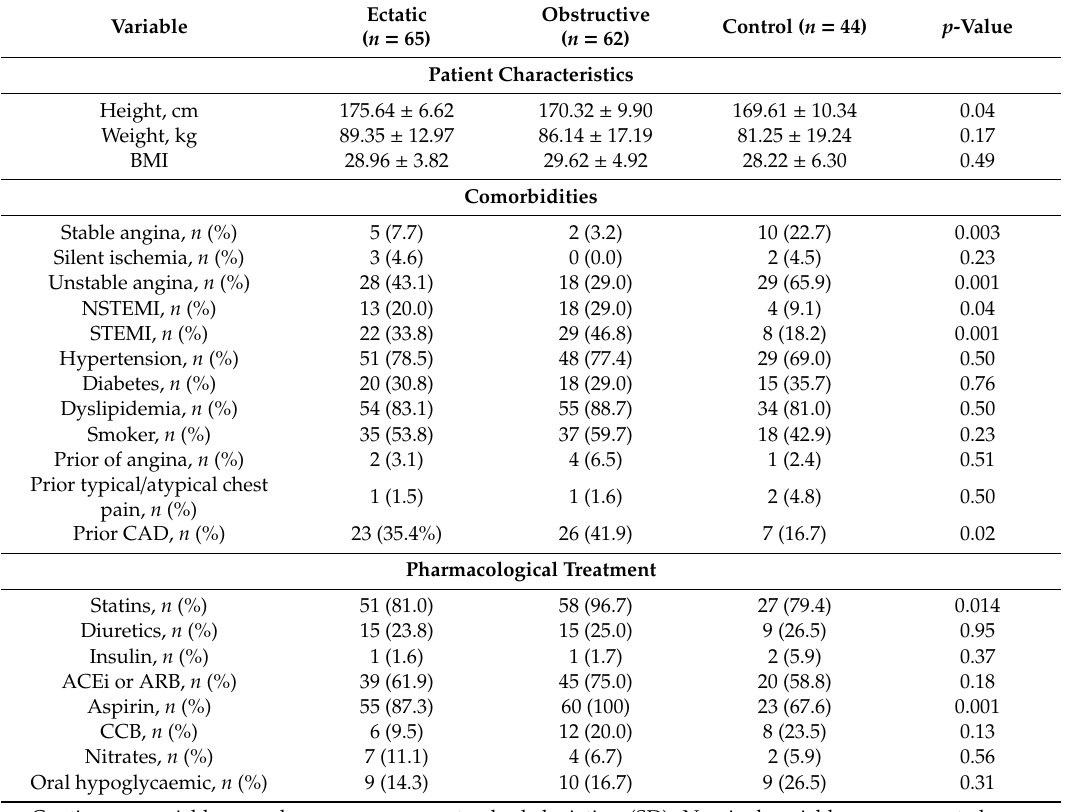
Table 1. Clinical and angiographic characteristics of the study group.